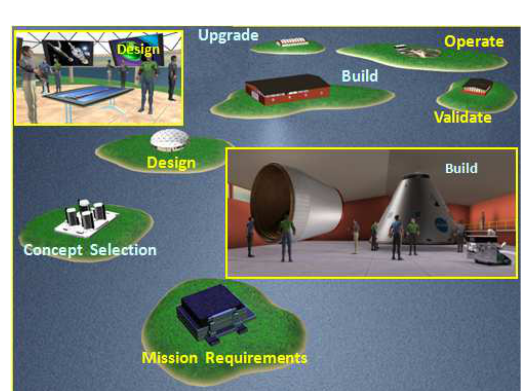
Figure 9. Massively Multiorganization Online Virtual Product Cre- ation (MMOVPC) Environment, with separate islands for each of the Product Creation